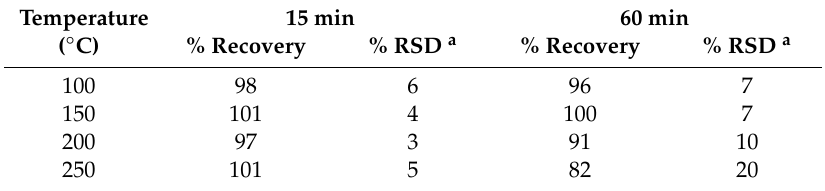
Figure 4. High-performance Liquid Chromatography chromatograms of coumarin after heating at 200 ◦ C. Phenol was used as the internal standard. Table 2. Percent recovery of coumarin obtained at di ff erent temperatures after heating.